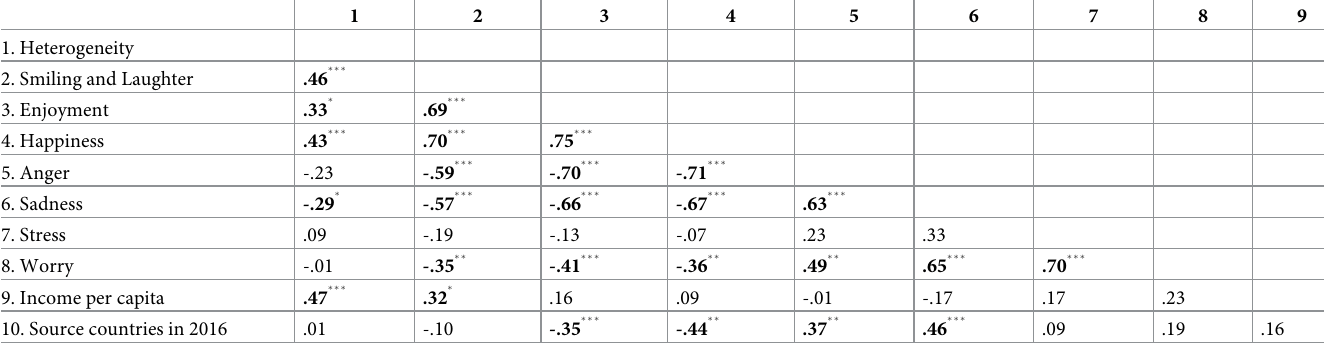
Table 2. Correlations between variables in Study